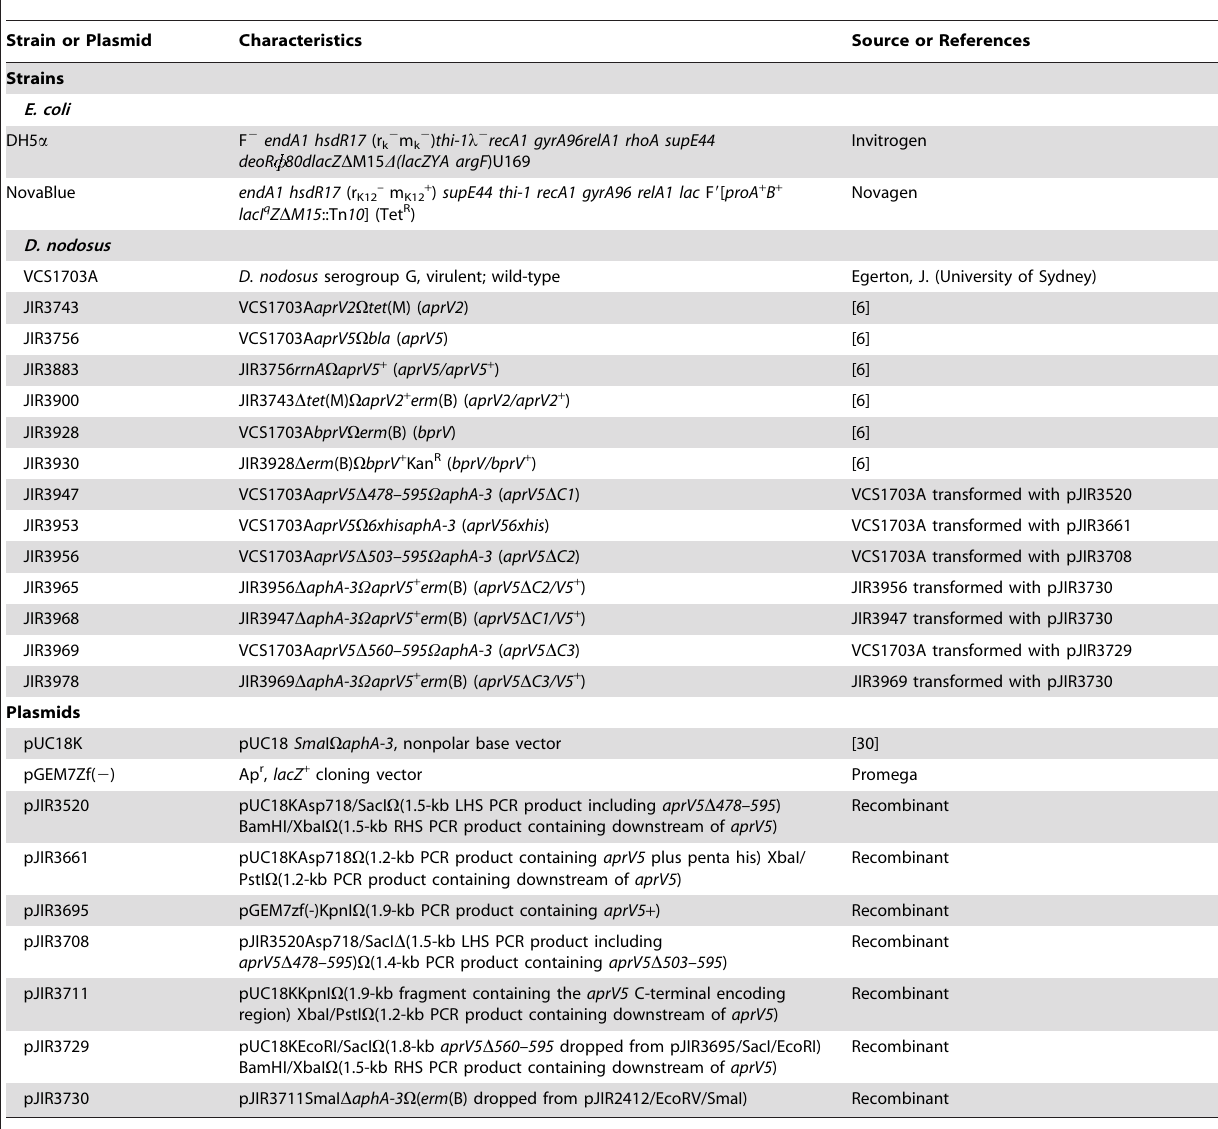
Table 1. Bacterial strains and